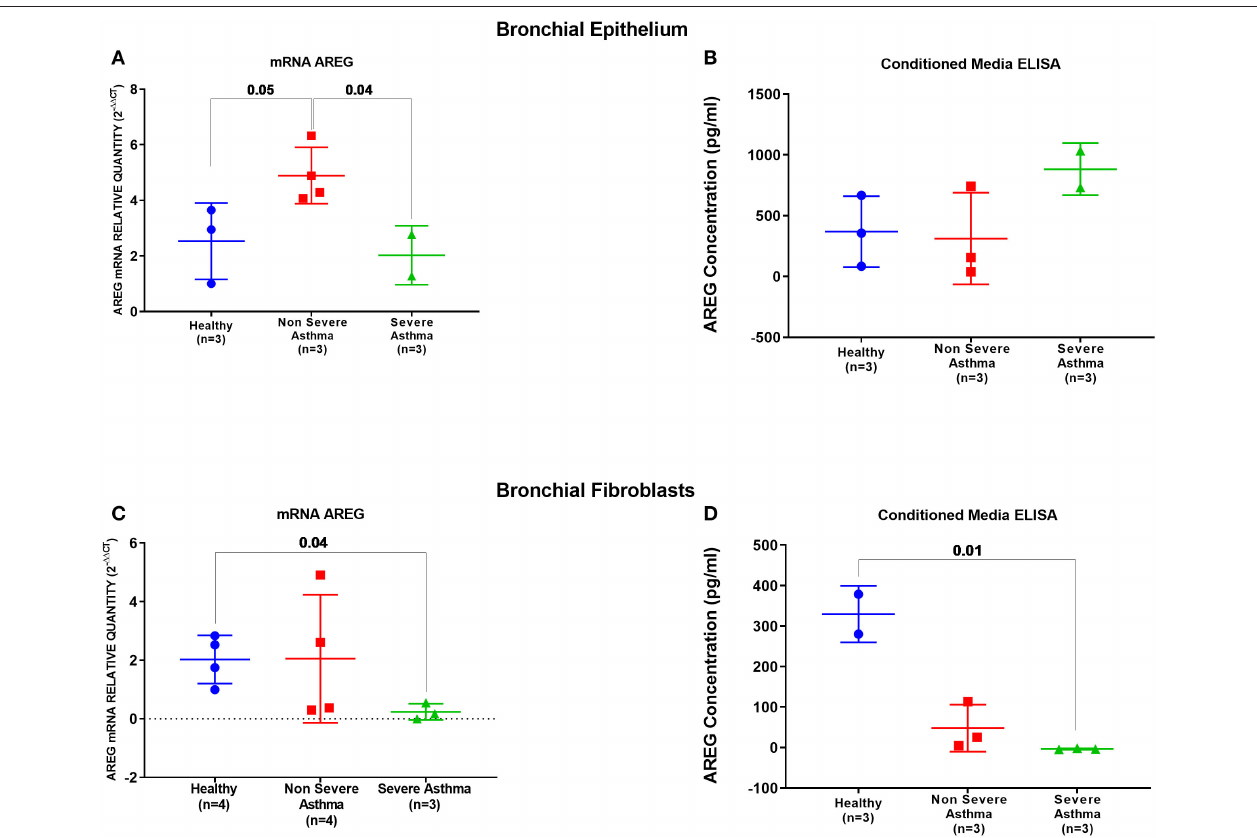
FIGURE 5 | AREG mRNA and secreted protein in bronchial epithelium cells and fibroblasts of healthy, non-severe, and severe asthmatic individuals. Assessment of AREG in asthmatic bronchial epithelium compared to the healthy epithelium on the (A) mRNA level measured by qRT-PCR, (B) secreted AREG protein levels by ELISA. Similarly, AREG was assessed in asthmatic fibroblasts compared to the healthy fibroblasts for the (C) AREG mRNA levels by qRT-PCR and (D) secreted AREG protein levels by